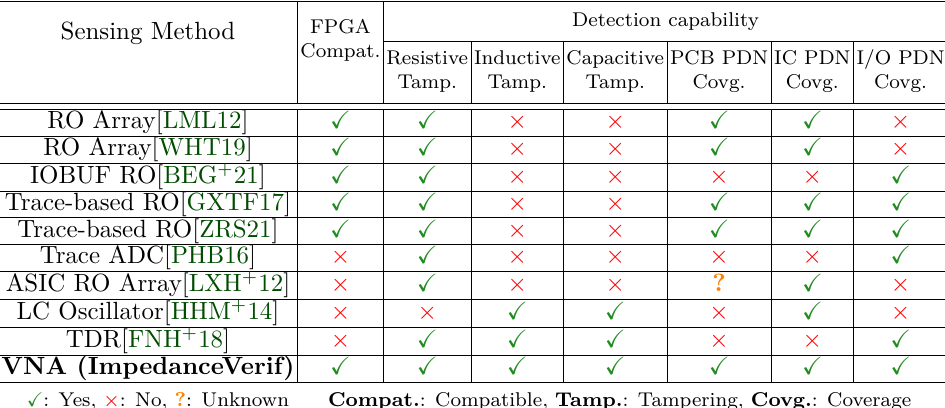
Table 1: The comparison between embedded sensing